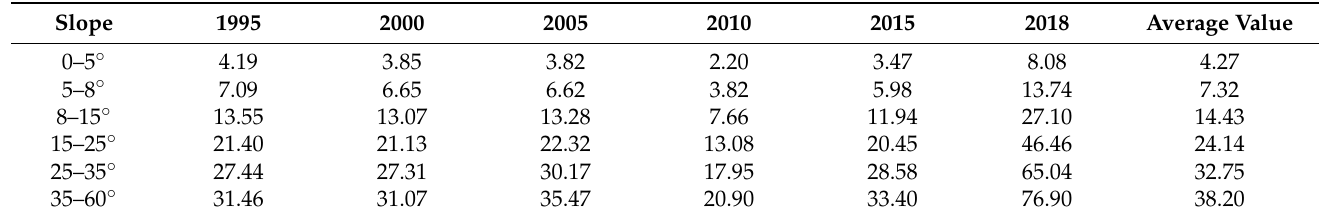
Table 3. Modulus of soil erosion in different years under different slopes in the South and North Mountains of Lanzhou (unit: t/(km 2 · a)).